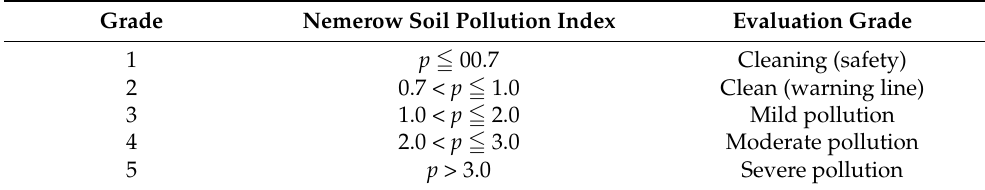
Table 3. Corresponding evaluation scores of evaluation index categories.